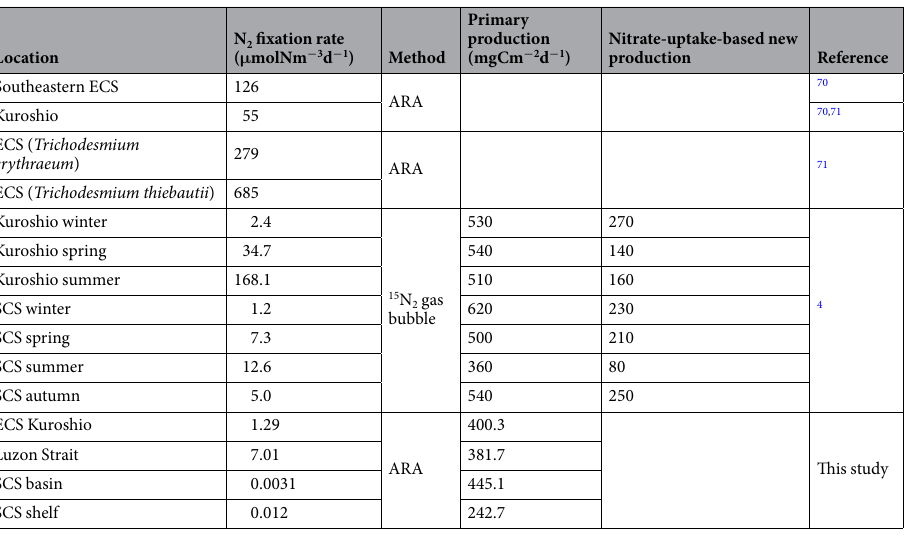
Table 4. Calculated Trichodesmium N 2 fixation rate in the South China Sea and the Kuroshio with literature reports of estimated N 2 fixation in the adjacent area. ARA = acetylene reduction